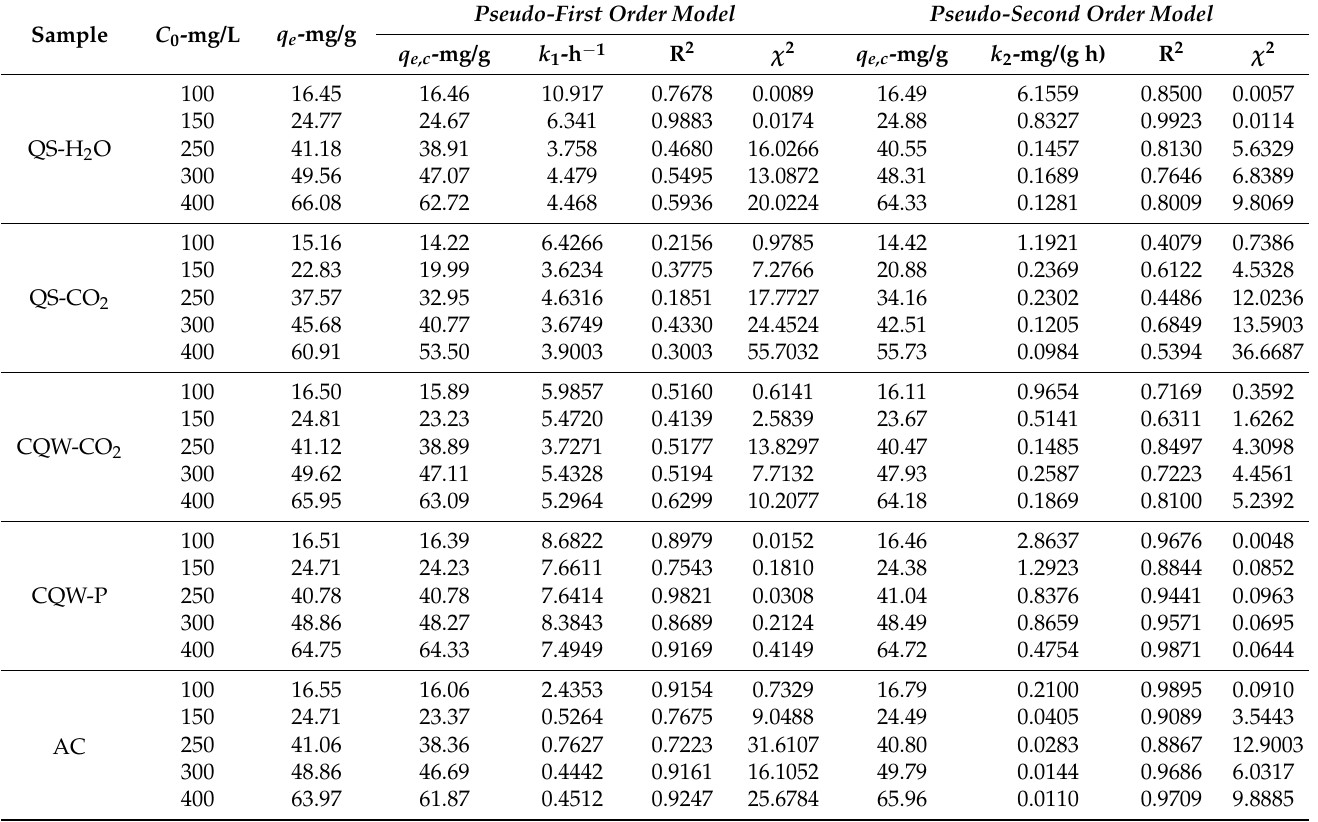
Figure 10. Pseudo-first (dash line) and second-order (solid line) kinetic fit for CV on CQW-CO 2 at different initial concentrations. Table 6. Kinetic parameters for CV adsorption on QS, CQW, and AC samples.